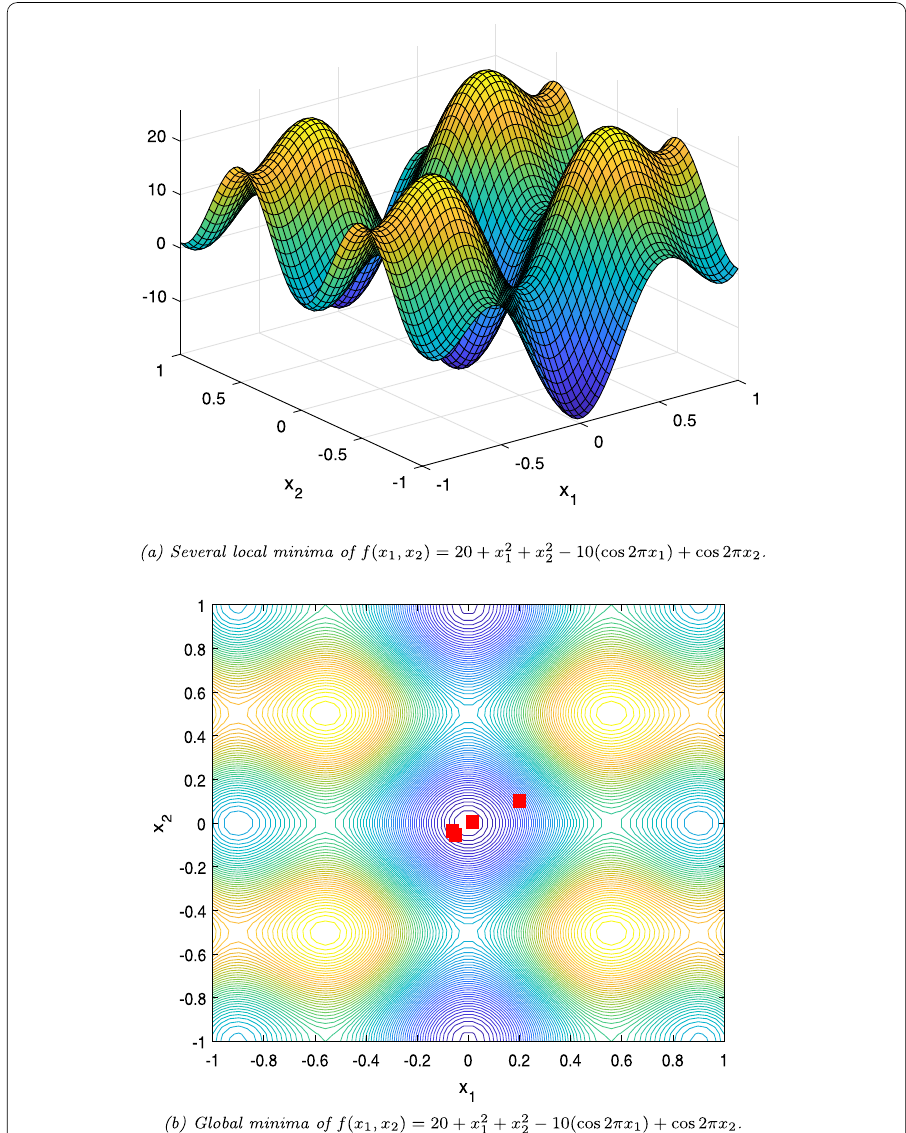
Figure 6 Visualization of Example 6